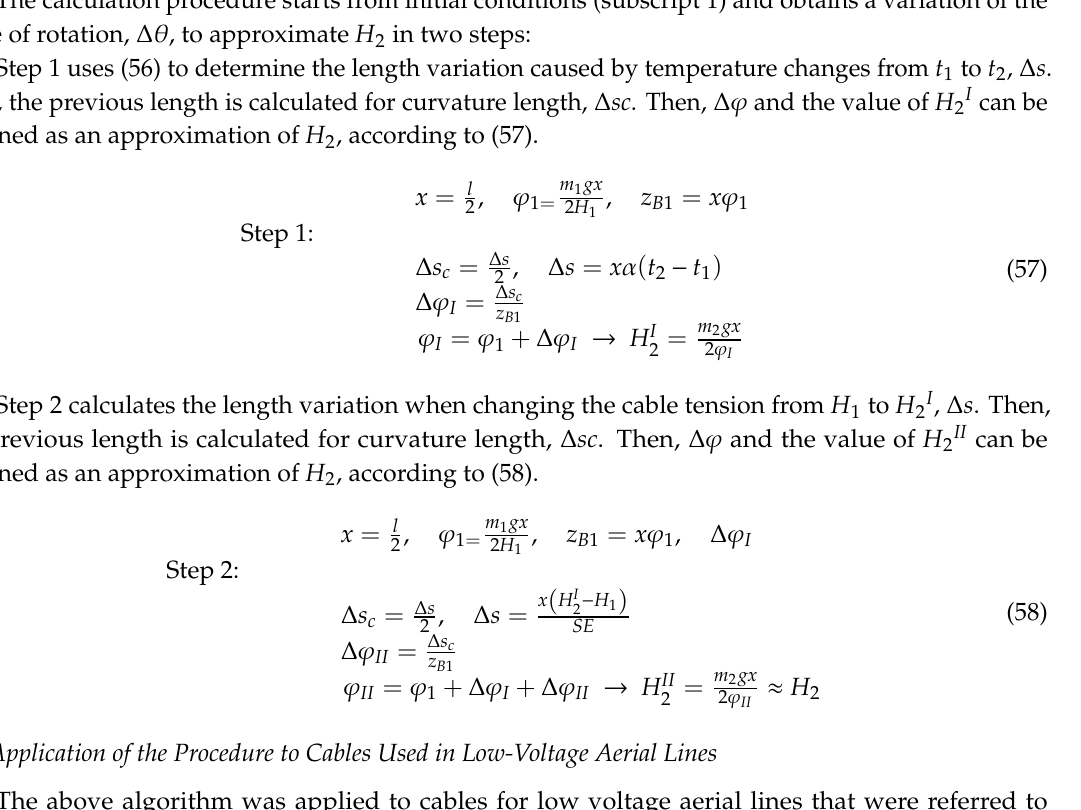
c according to Equation (56).